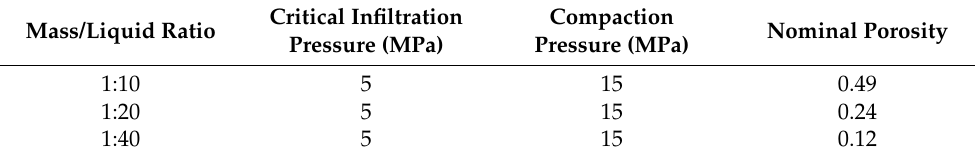
Table 2. Parameter settings of silica-aerogel functionalized liquid with different mass/liquid ratios. Mass/Liquid Ratio